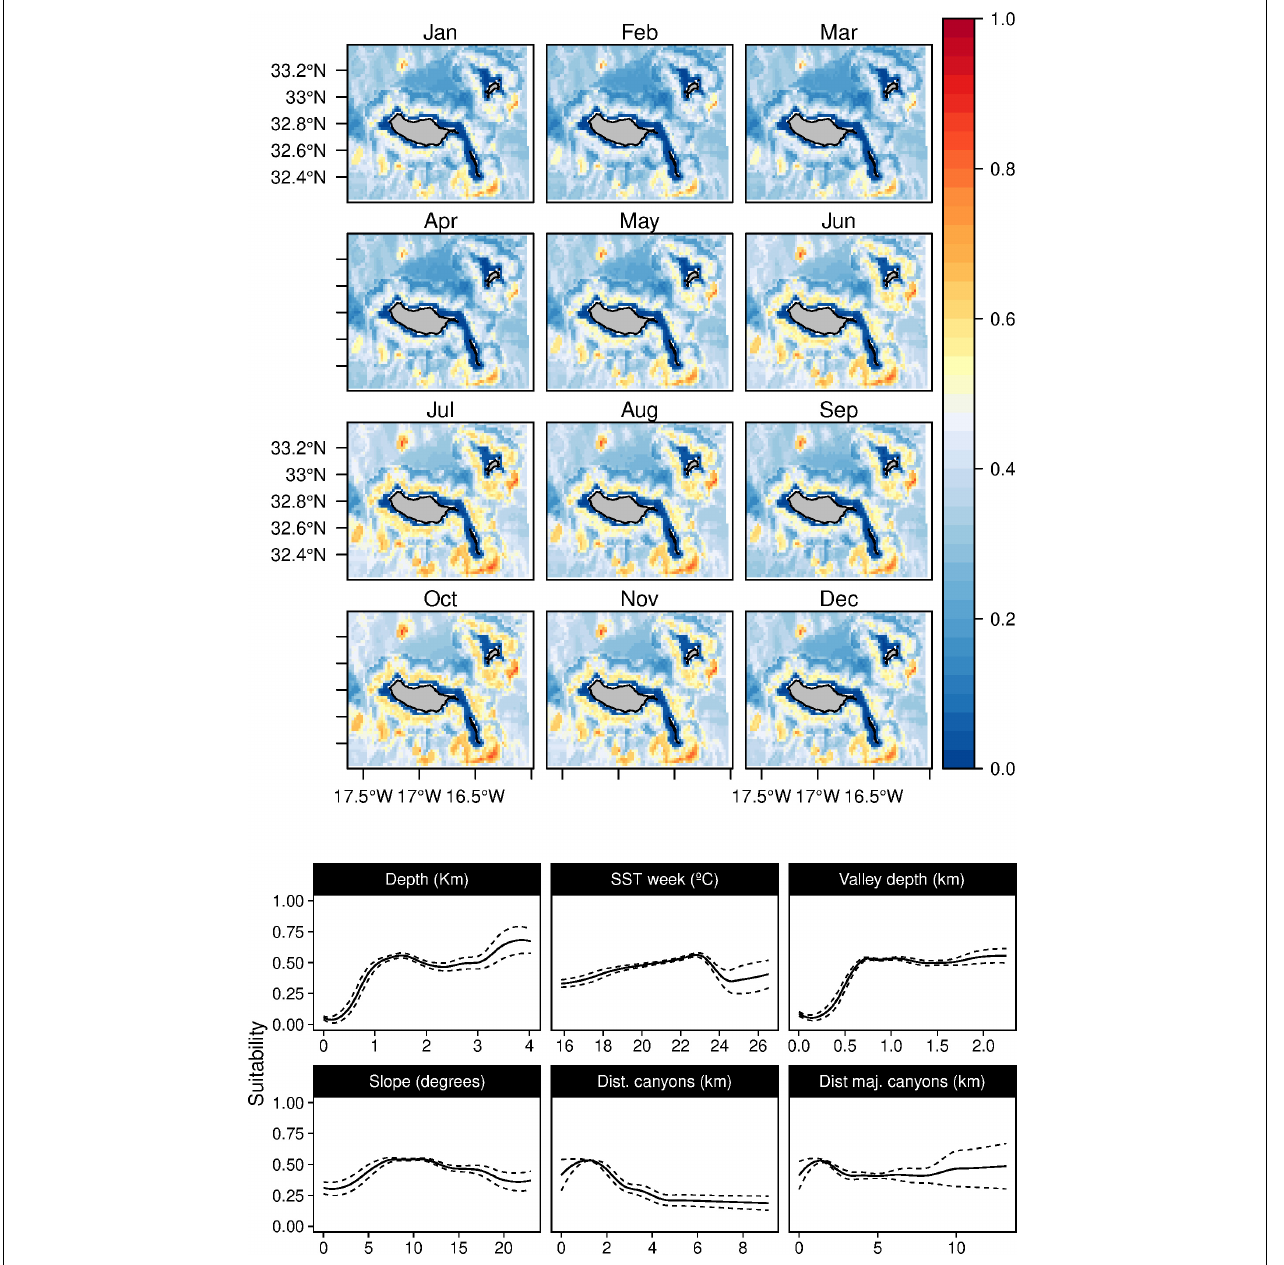
FIGURE 3 | Mean monthly suitability maps (above) and smoothed response curves with standard deviation (below) in the Madeira archipelago for Physeter macrocephalus for the “8-days” models. In the maps, red represents more suitable and blue less suitable. Responses curves are ordered by percent contribution of the environmental